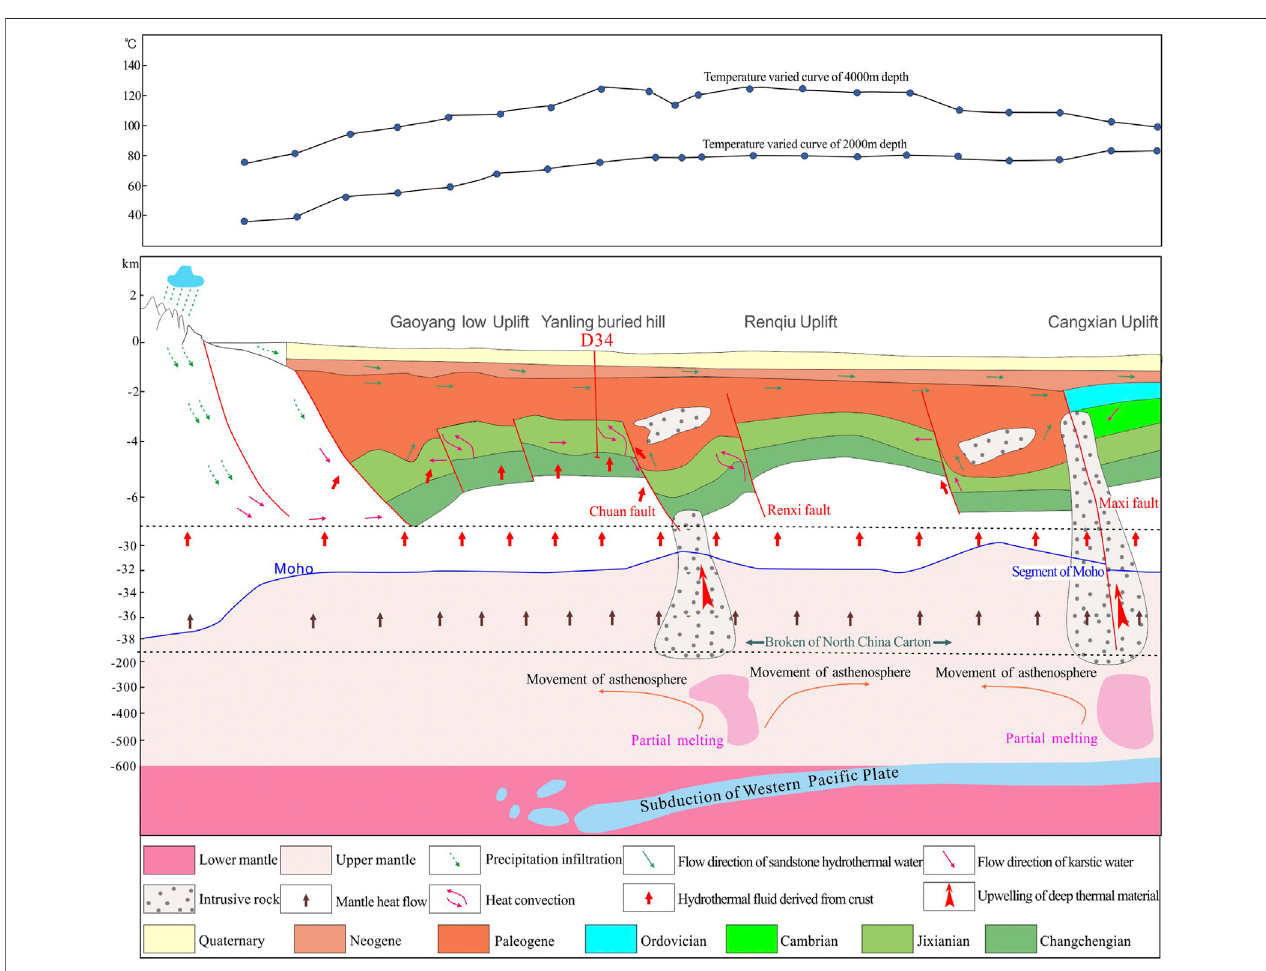
FIGURE 12 | Heat accumulation model of deep ancient buried hill in the northeast of the Gaoyang geothermal fi eld.